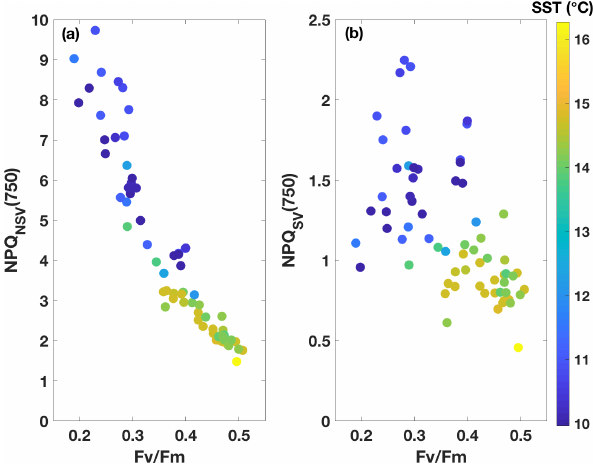
Figure 3. FRRf results from underway samples ( n = 66). NPQ ca- pacity at a light intensity of 750µmolquantam − 2 s − 1 is plotted against F v /F m , with two different NPQ parameterizations used as follows: normalized Stern–Volmer (a) and Stern–Volmer (b) . Colour indicates SST of the corresponding